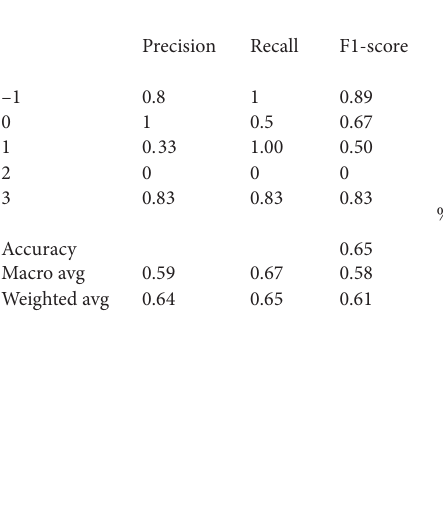
Figure 17: Accuracy report with “ k �